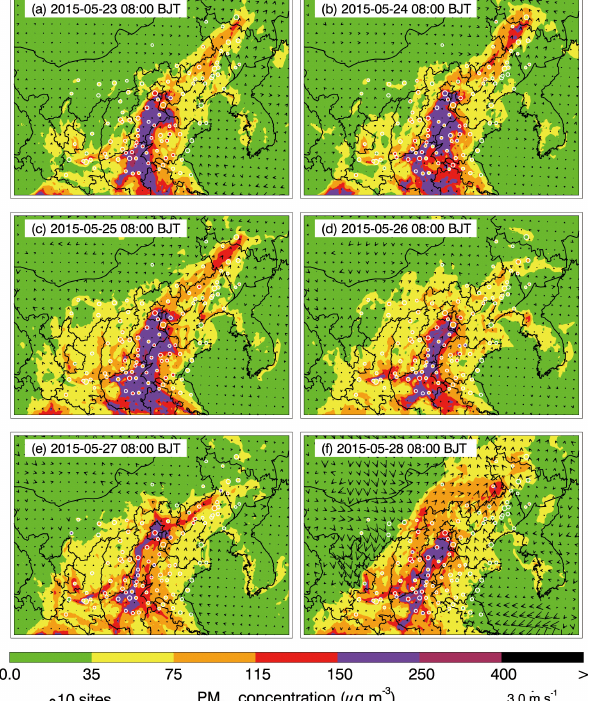
Figure 7. Pattern comparison of simulated vs. observed near- surface PM 2 . 5 at 08:00BJT from 23 to 28 May 2015. Colored cir- cles show PM 2 . 5 observations, color contours show the PM 2 . 5 sim- ulations, and black arrows represent the simulated surface winds.